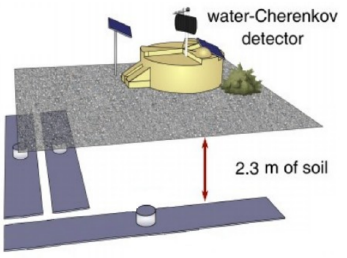
Figure 2. Schematics of the final UMD design with three mod- ules of 10 m 2 .